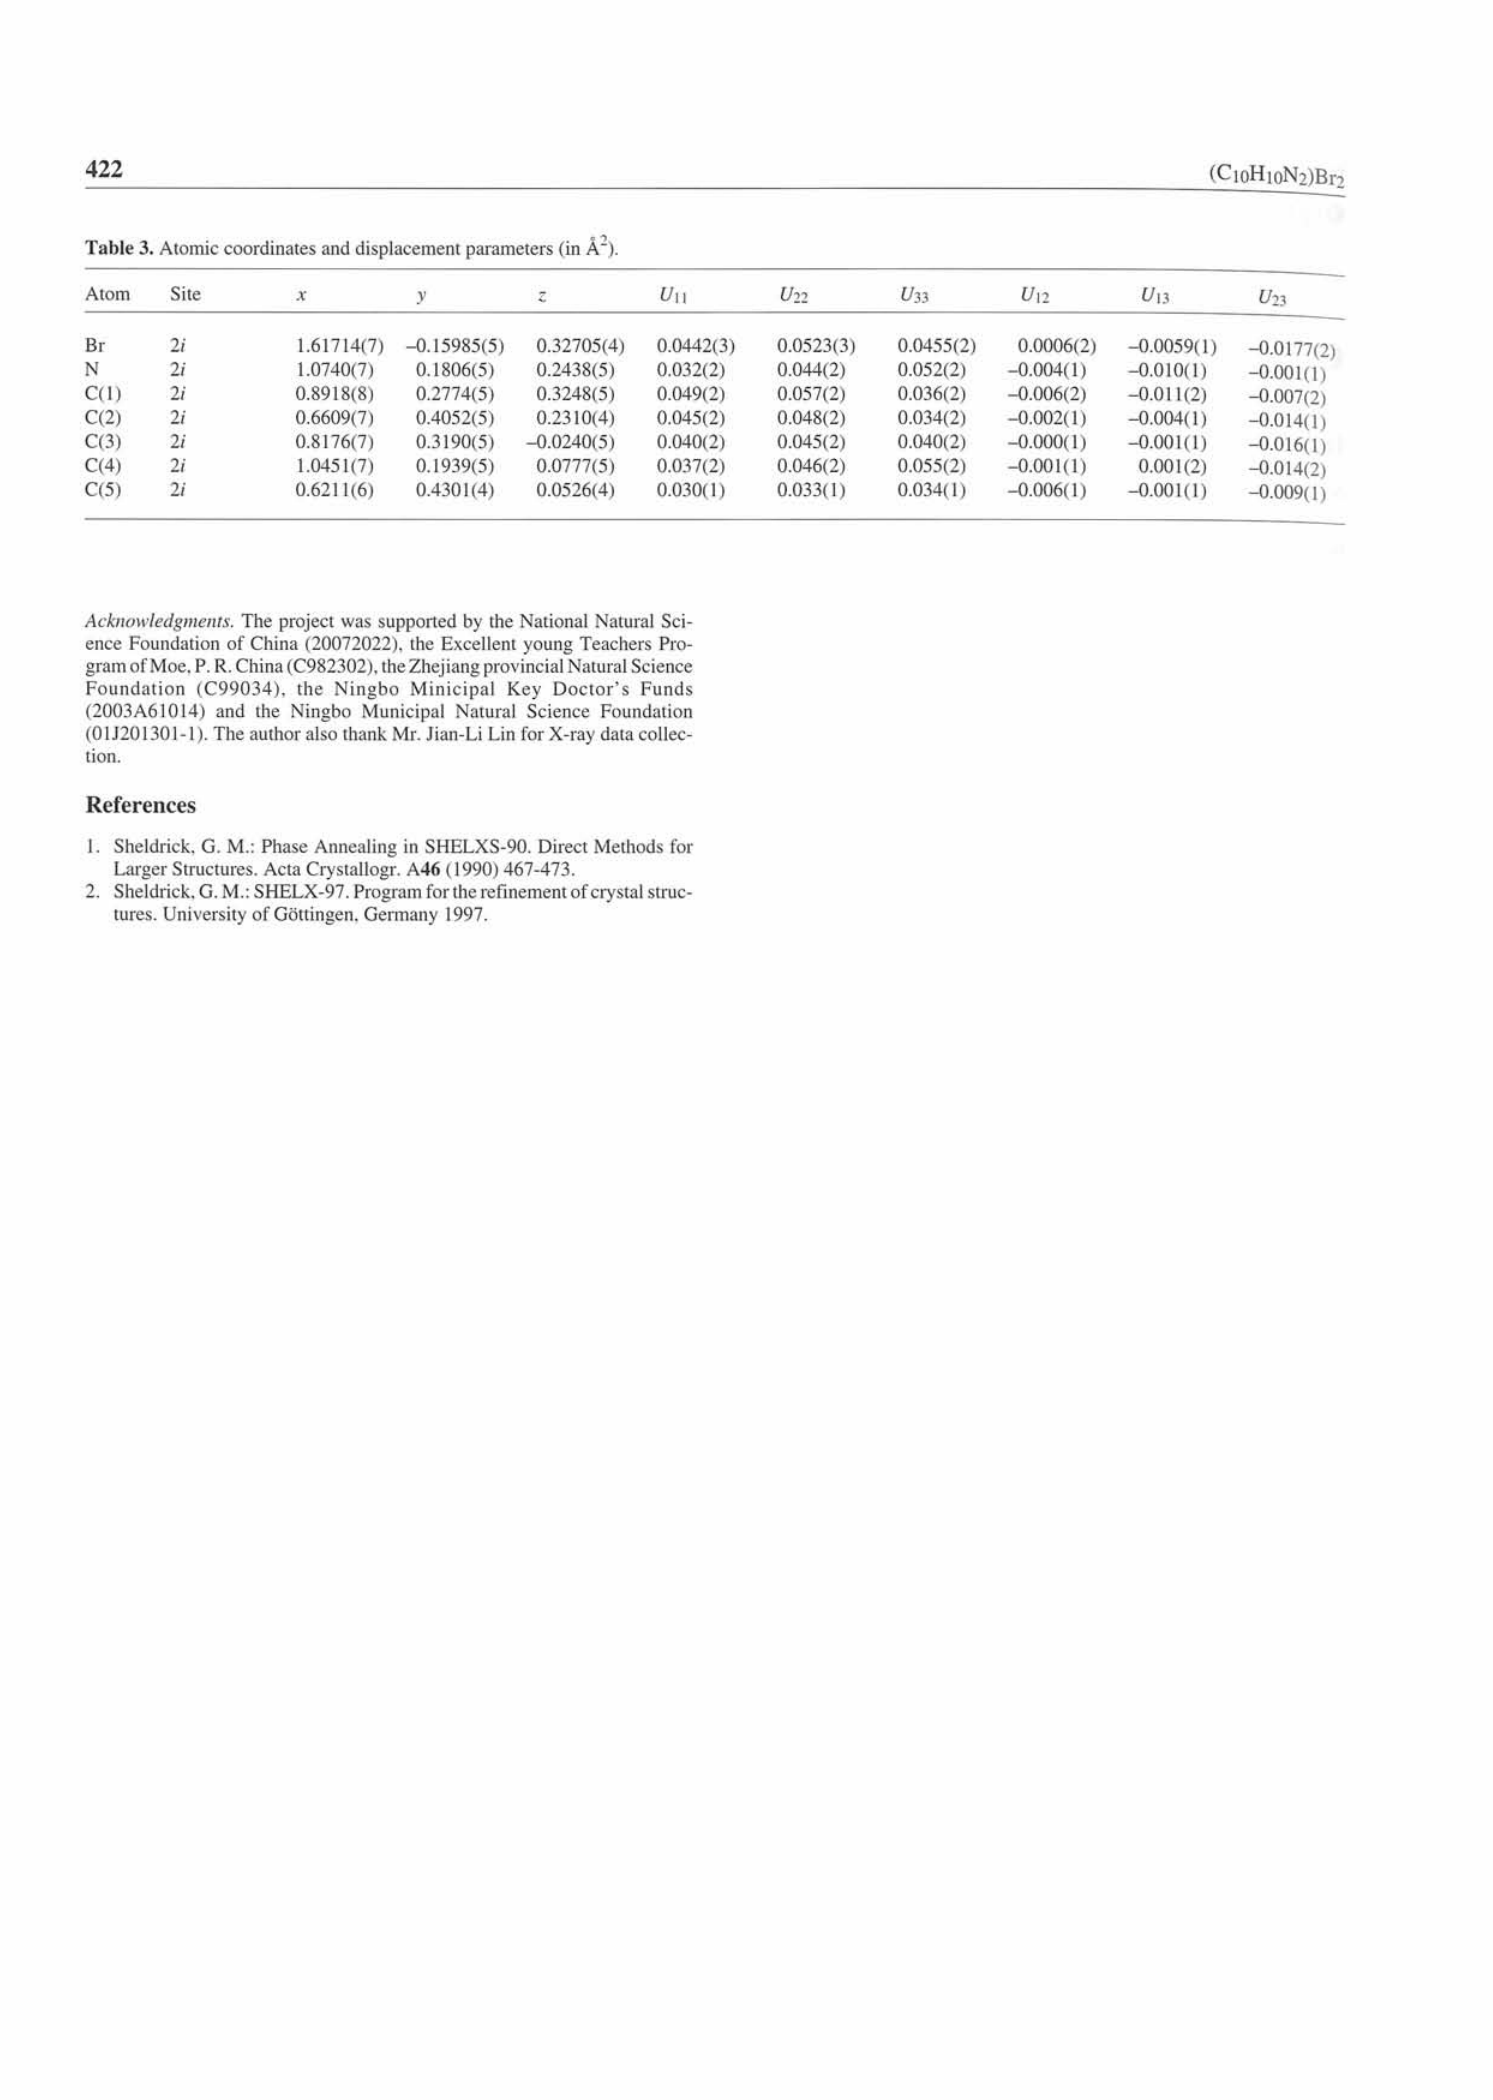
Table 3. Atomic coordinates and displacement parameters (in